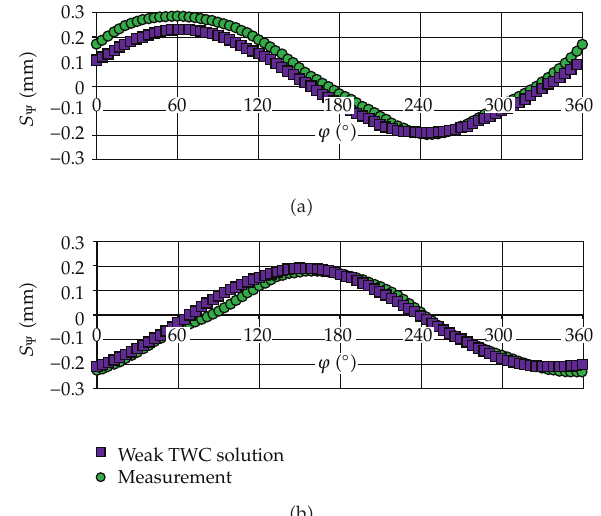
Figure 18: Comparison of calculated and measured